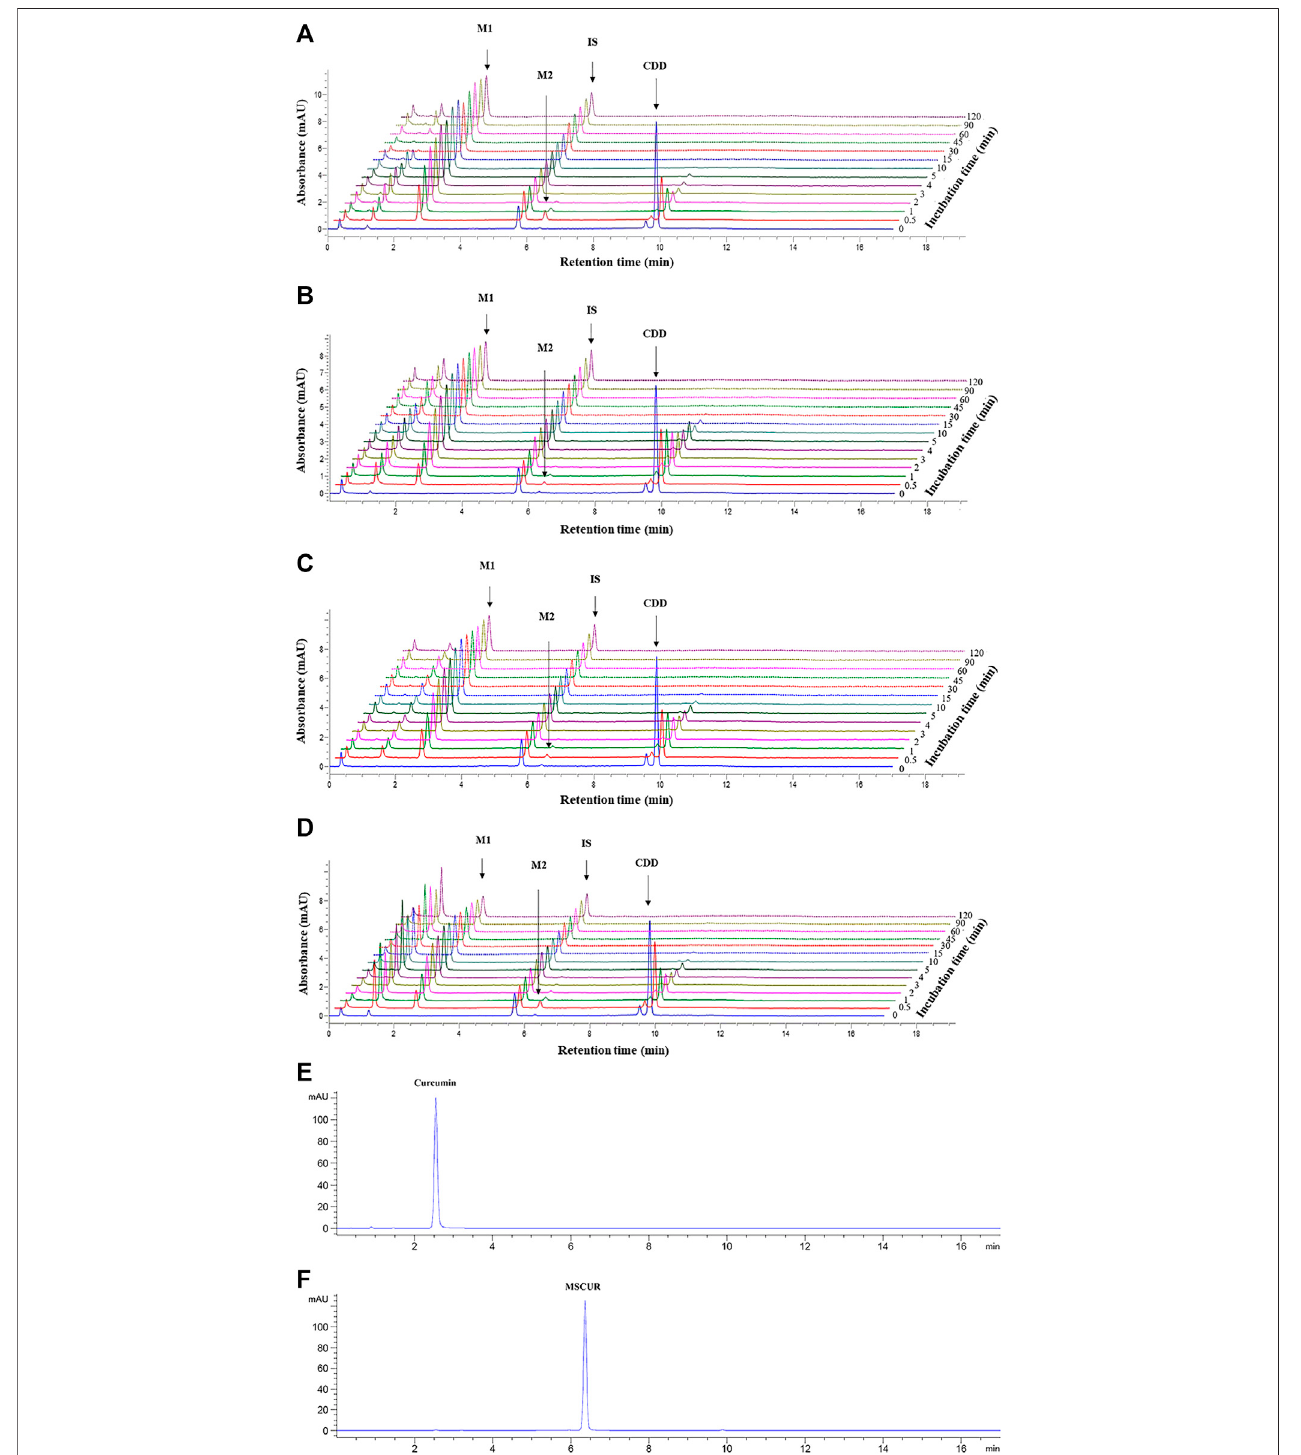
FIGURE3 | UHPLC chromatogramsofCDD and its metabolites in (A) HLS9, (B) MLS9, (C) DLS9,and (D) RLS9 asafunction ofincubation time. CDD (3 µM) was incubated with HLS9, MLS9, DLS9, and RLS9 (1 mg/ml) at 37 ° C. (E,F) are UHPLC chromatograms of standard curcumin and MSCUR, respectively.